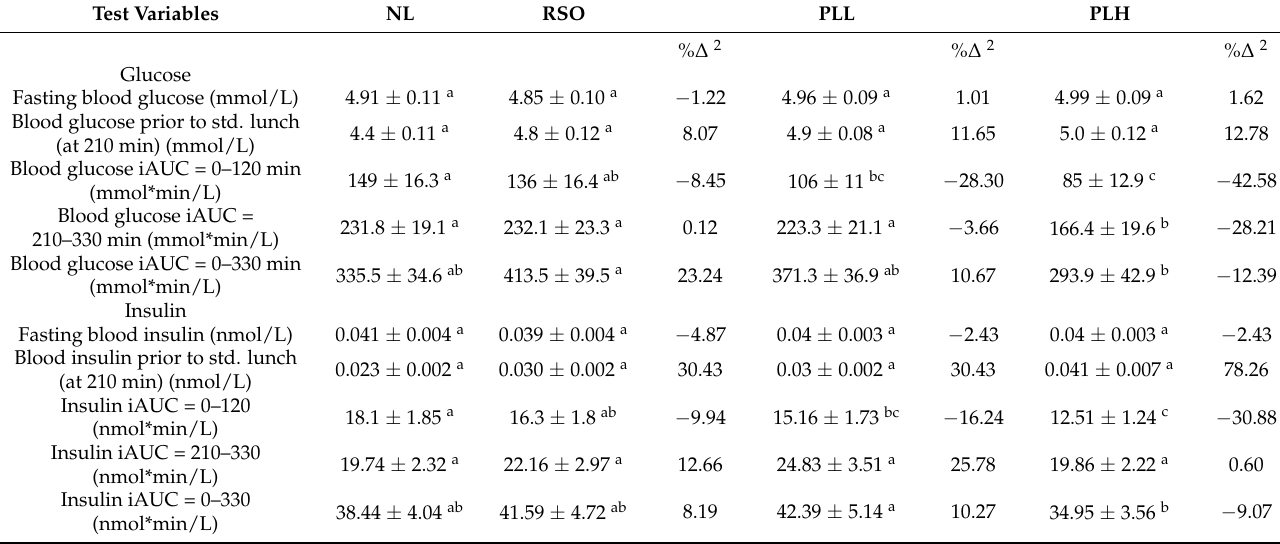
Figure 2. Incremental changes in serum blood glucose concentrations after test breakfasts and standardized lunch meals. Values are means ± SEM, n = 20 healthy subjects. Repeated measures; mixed model in SAS. NL, oat preparation without added lipids; RSO, oat preparation added with rapeseed oil; PLL, oat preparation with a low concentration of polar lipids; PLH, oat preparation with a high concentration of polar lipids. Table 3. Blood glucose and insulin concentrations at fasting and after consumption of test meals at breakfast, followed by a standardized lunch meal 1